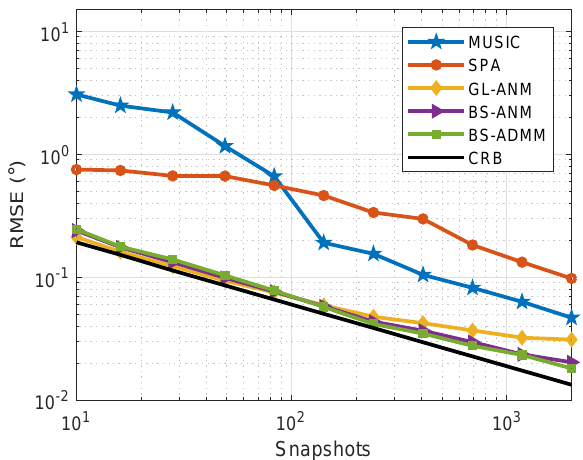
Figure 8. RMSE comparison for correlated sources at θ = 5 ◦ and θ = − 10 ◦ , SNR = 0 dB when the number of snapshots varies from 10 to 2000, ζ =